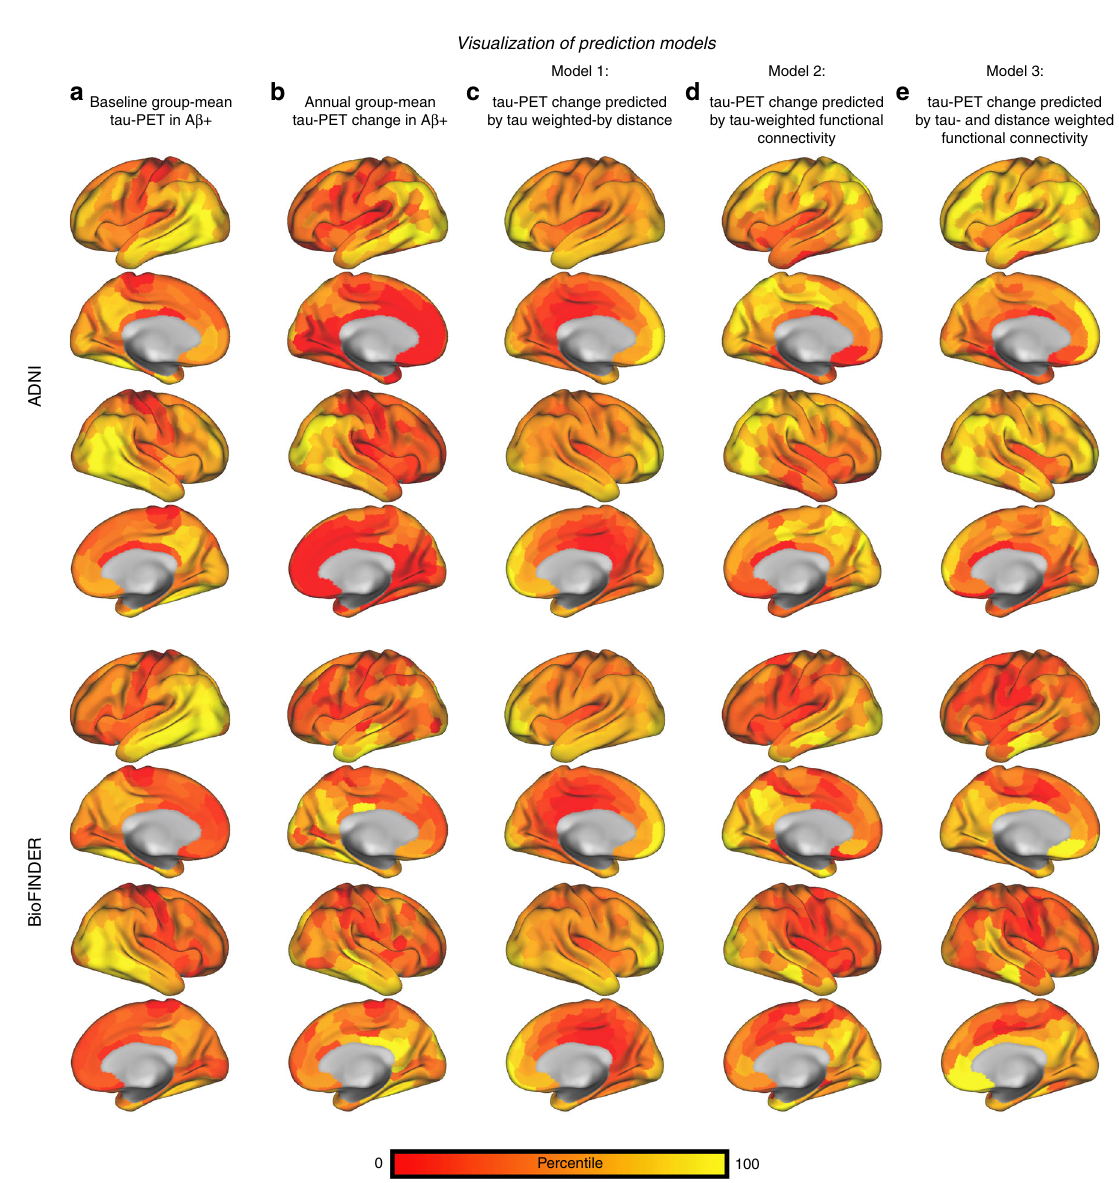
Fig. 8 Surface rendering of predicted tau-PET change. Surface renderings of percentile-transformed group-mean tau-PET at baseline ( a ) and annual tau- PET change ( b ) for A β + subjects of the ADNI ( N = 53) and BioFINDER ( N = 41) sample. The prediction of tau-PET change from Models 1 – 3 shown in Fig. 7 is illustrated via surface renderings in ( c – e